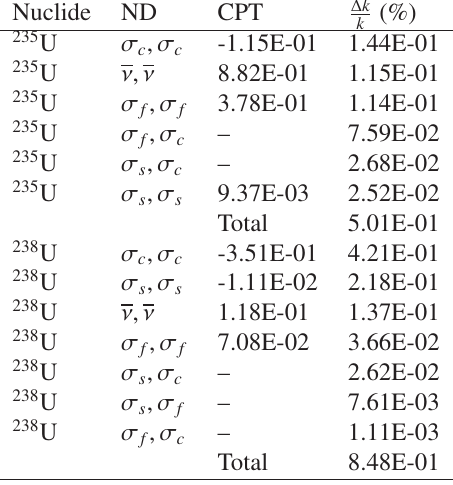
Figure 2. The sensitivity per unit lethargy of k to the 1 H capture